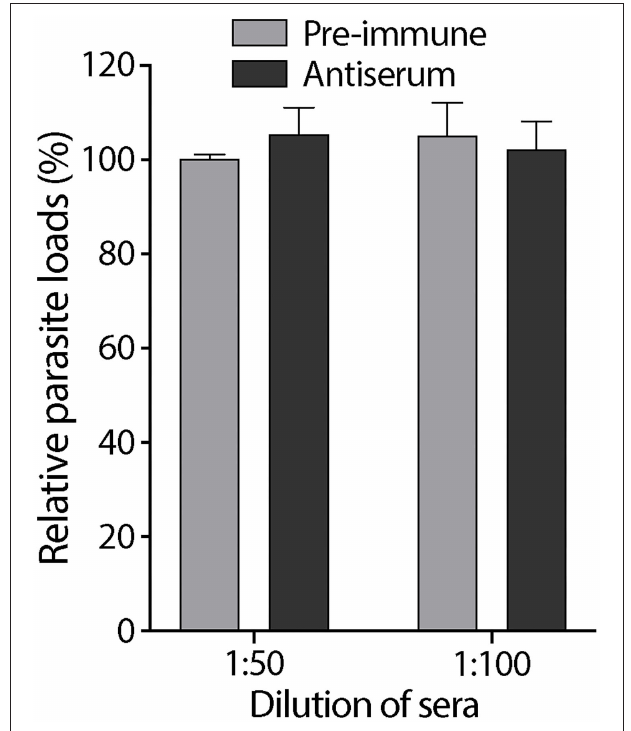
FIGURE 9 | Effect of rabbit antiserum against CpROM1 and pre-immune serum at 1:50 and 1:100 dilutions on C. parvum sporozoite infection of HCT-8 cells in vitro . HCT-8 cell monolayers were inoculated with excysted sporozoites for 2h to allow invasion, washed to remove non-invading sporozoites, and allowed to grow for an additional 16h. Pre-immune serum and antiserum were included in the invasion and intracellular growth stages. Blank control was subjected to the same infection procedure but with no serum treatment. Relative parasite loads were determined using qRT-PCR, with the blank control as the baseline.